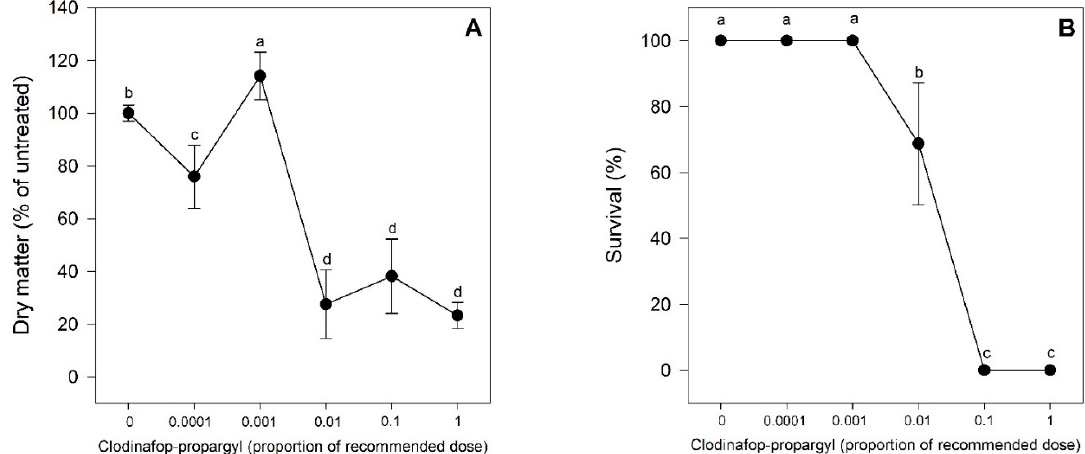
Figure 1. Dry matter accumulation ( A ) and survival ( B ) of susceptible Avena fatua L. plants treated with clodinafop-propargyl in proportional doses of the recommend rate (1x, 0.1x, 0.01x, 0.001x, 0.0001x, and 0x). Statistical significances are indicated with different letters. Datapoints represent mean values, and vertical bars represent standard errors. When they are absent, they are smaller than the symbol ( n = 4).